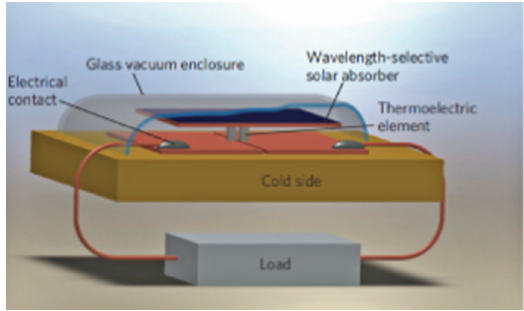
Figure 15. Illustration of a STEG cell consisting of a pair of thermoelectric elements type p and n [158].